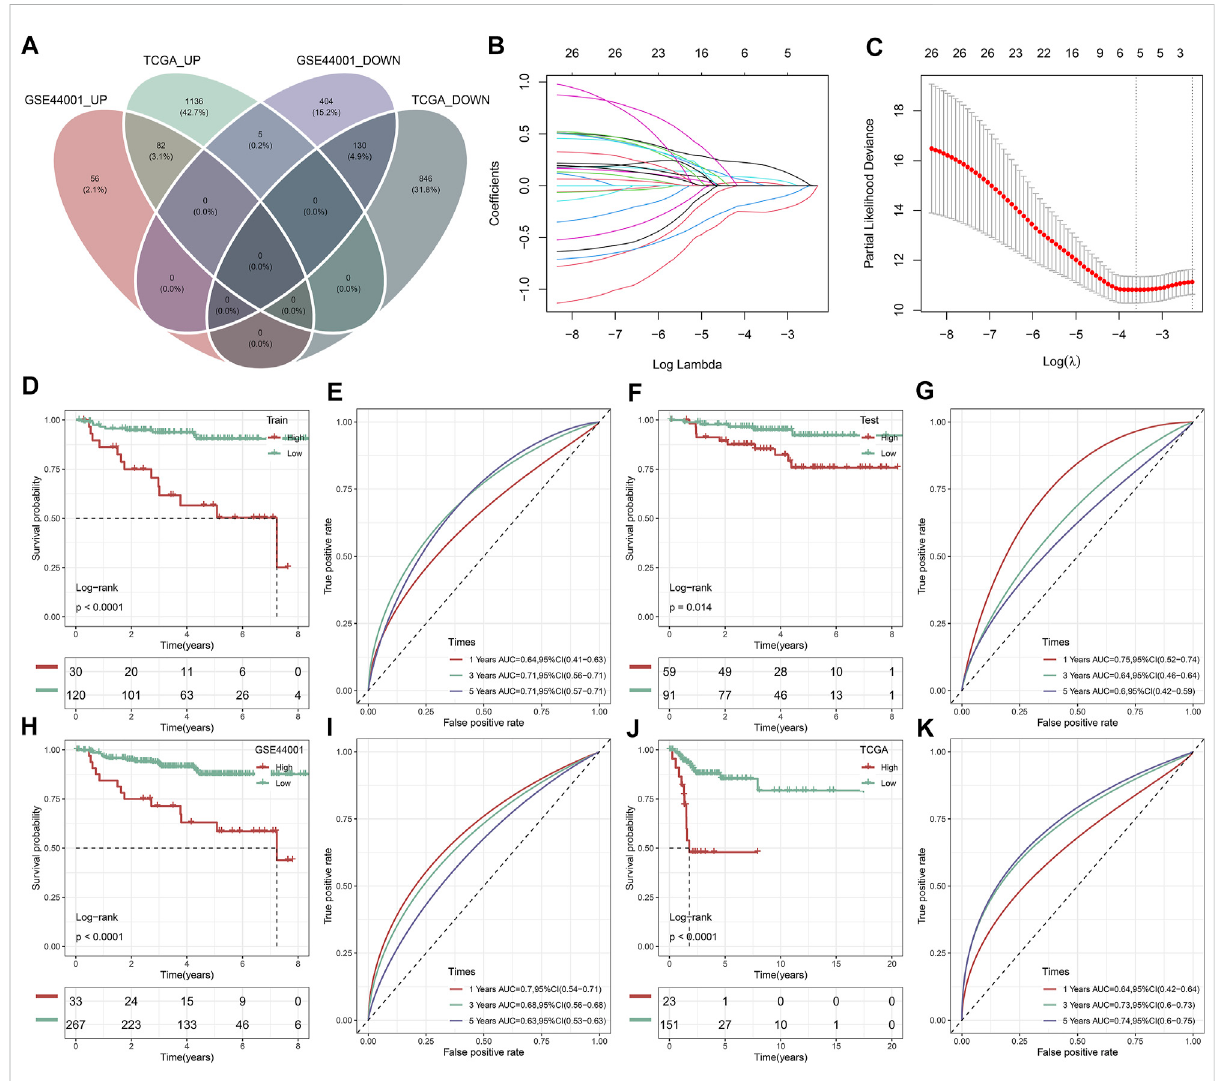
FIGURE 8 Constructionandveri fi cationofan immune subtype-relevantrecurrencemodelfor cervicalcancer. (A) VenndiagramofsharedDEGs between IC1 and IC2 immune subtypes both in the TCGA and GSE44001 datasets. (B) Landscape of regression coef fi cients of 26 recurrence-related DEGs in the training set. (C) Selection of the optimal tuning parameter λ via 10-fold cross-validation. Kaplan-Meier curves of DFS and ROC curves at 1-, 3-,